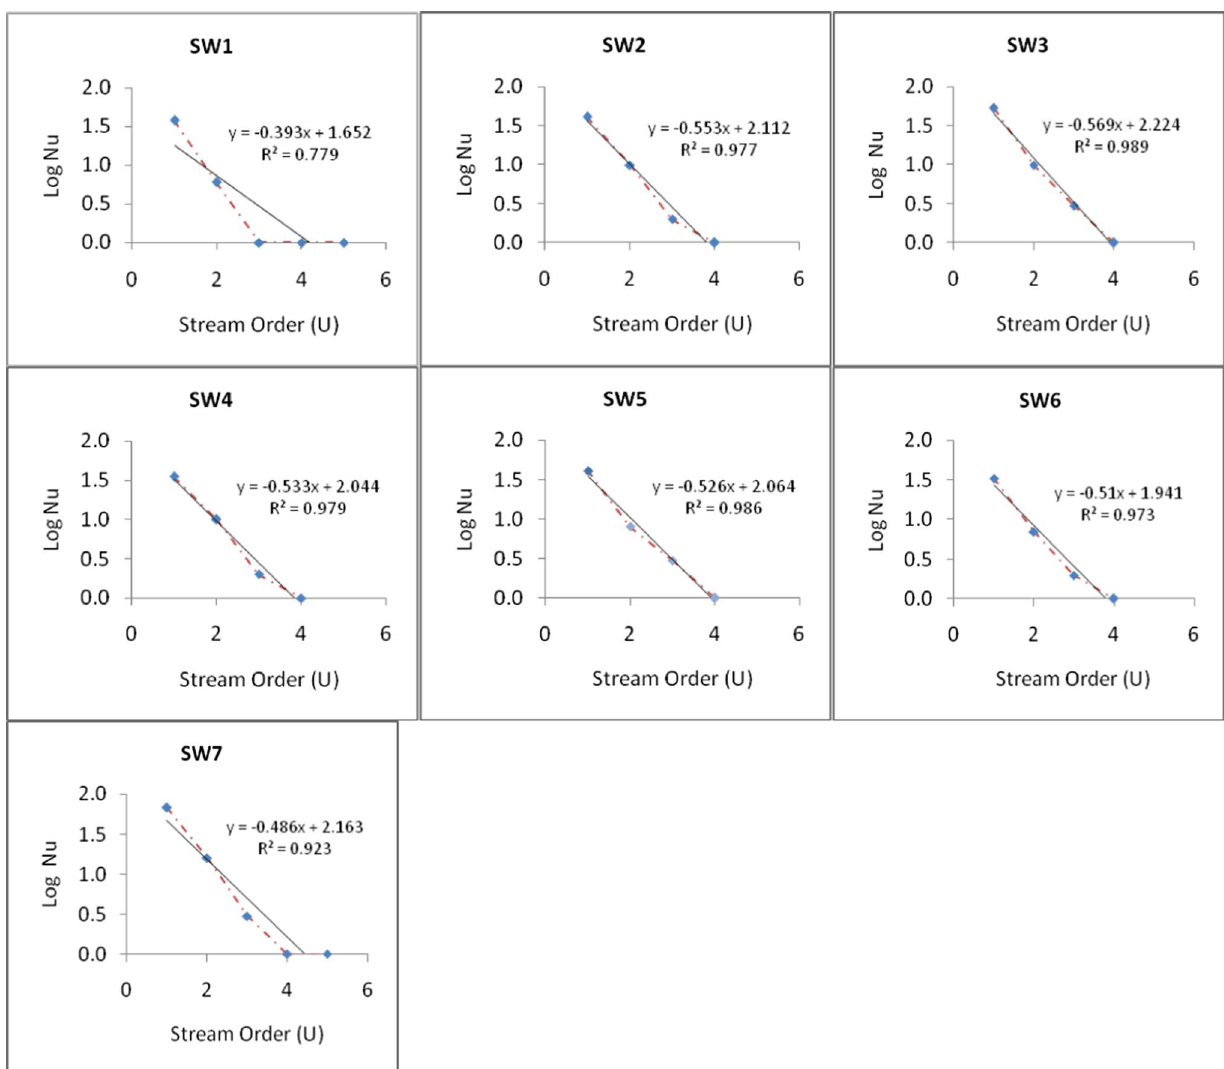
Fig. 4 Relationship between stream order and stream